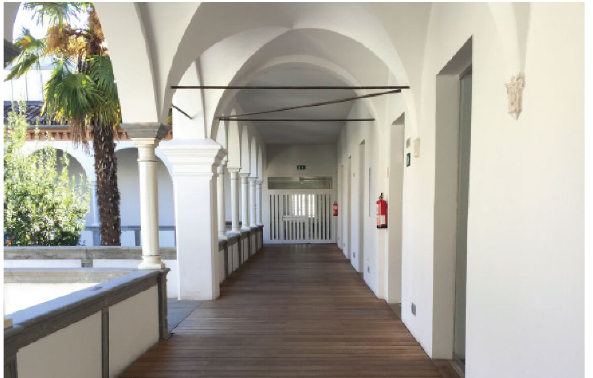
Figure 6. View of the Galeria, first floor – HBIM model